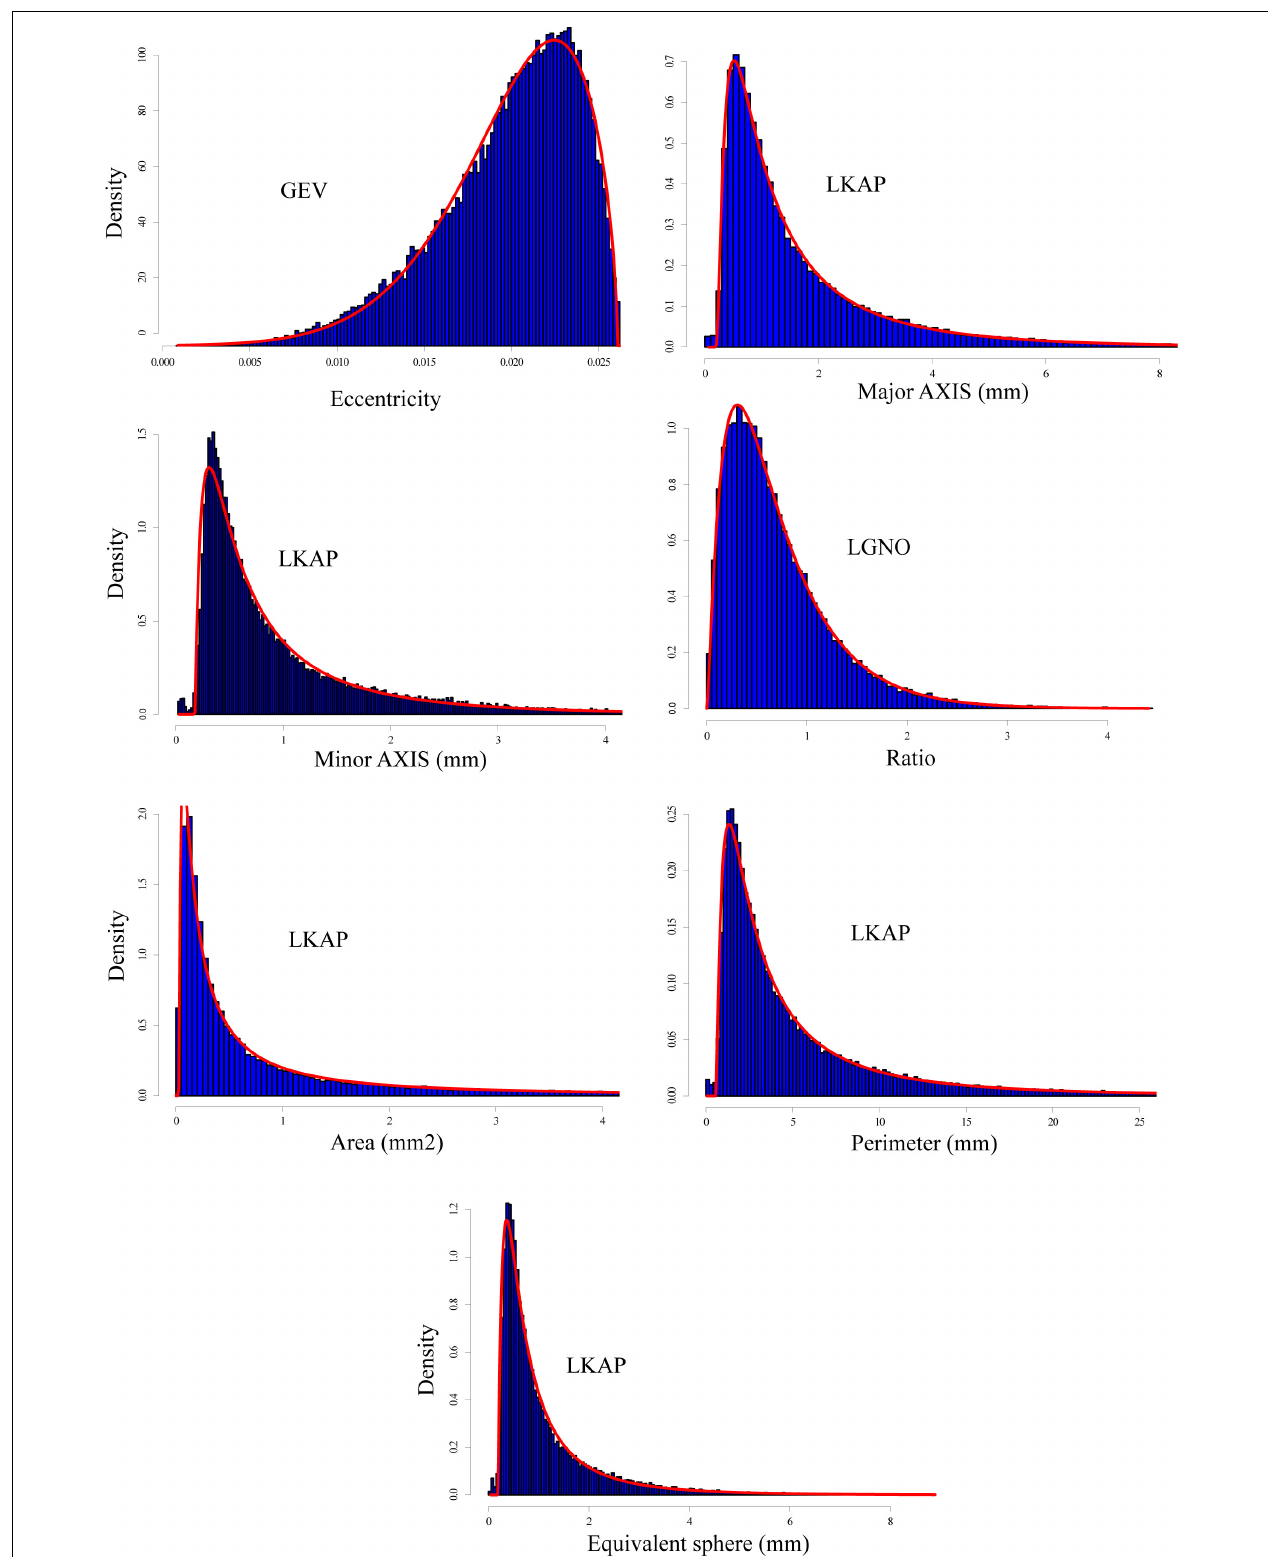
FIGURE 6 | Same as Figure 3 but for all snow grains classified as “depth hoar” with a total of 48,387 grains.